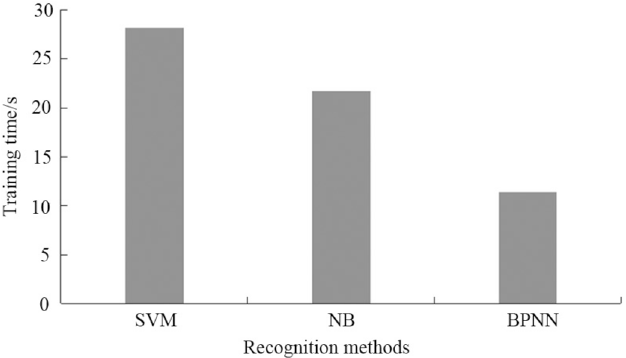
Table 3. Real-time control results of mechanical simu- lated